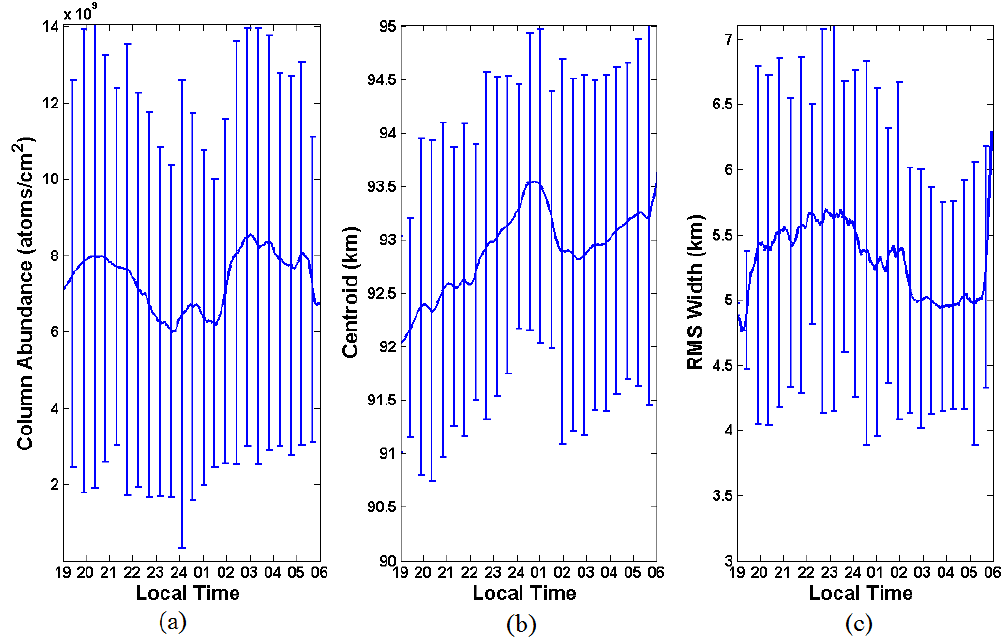
Fig. 9. Mean temporal variations of (a) column abundance, (b) centroid height and (c) RMS width obtained from the year 2005 and 2006.